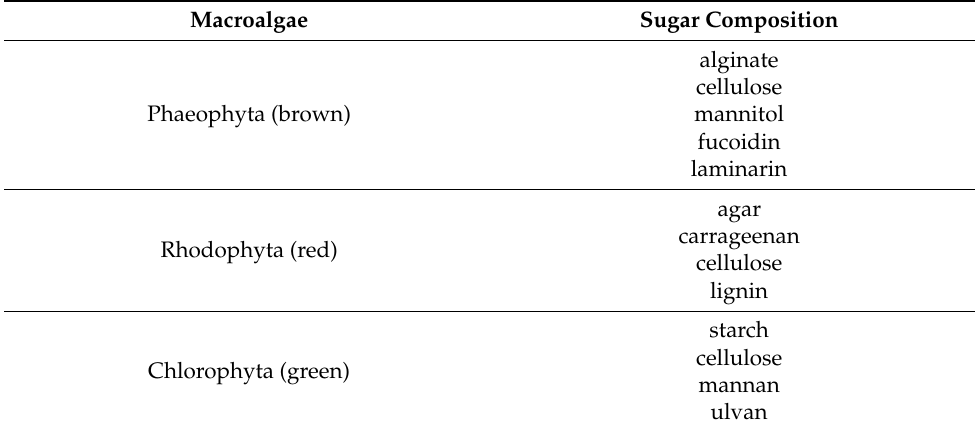
Table 1. Different macroalgae sugar